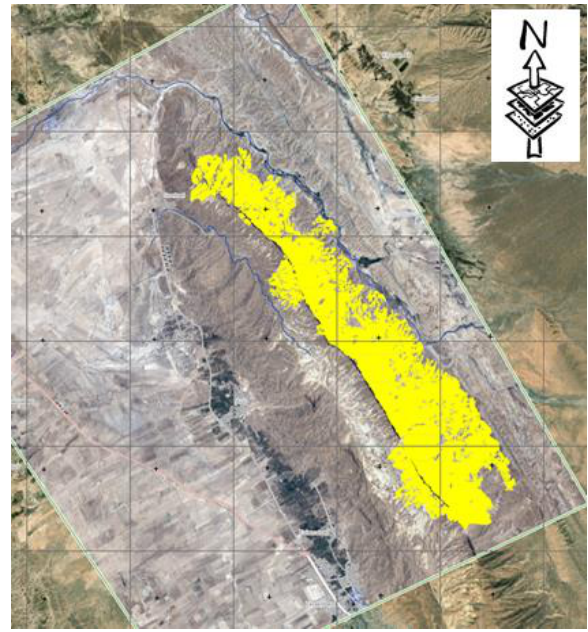
Figure 2. The EMS map to evaluate the result. In the current research, the Level-1C products available at GEE (Dataset ID: "COPERNICUS /S2_SR") were used. In the first phase, the Sentinel-2 dataset was mosaicked in the GEE web- based platform to fully cover the study region. Subsequently, mosaicked images were atmospherically restored to the reflectance of the L-2A bottom of atmosphere (BOA) using the Sen2cor (Farhadi et al., 2022b), and resampled to a spatial resolution of 20 m. Ultimately, atmospherically corrected images were used for the calculation of the spectral index. The used Sentinel-2A image scenes related to before and after the fire is shown in Figure 3.